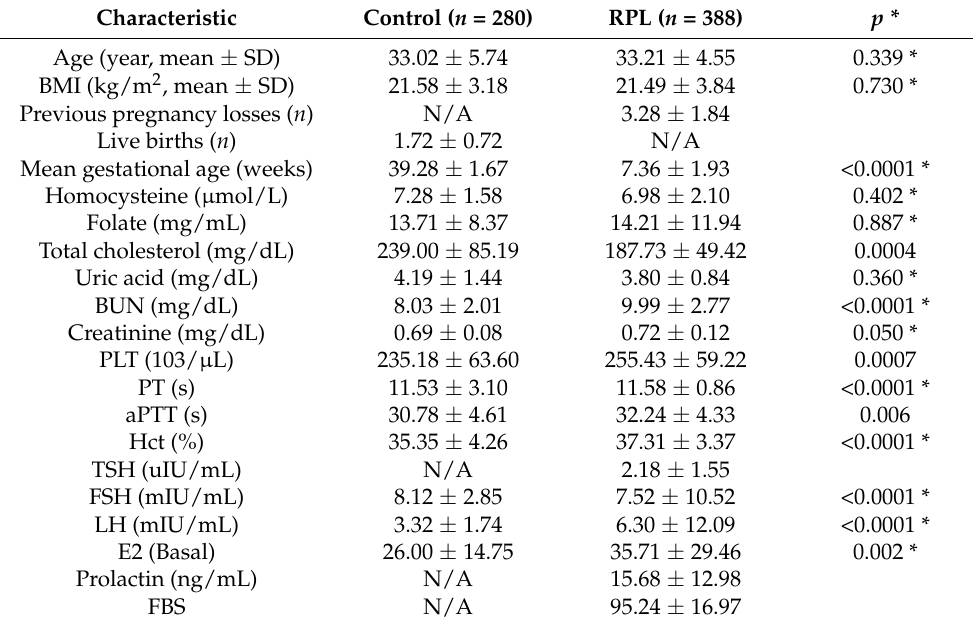
Table 1. Clinical characteristics of control and RPL